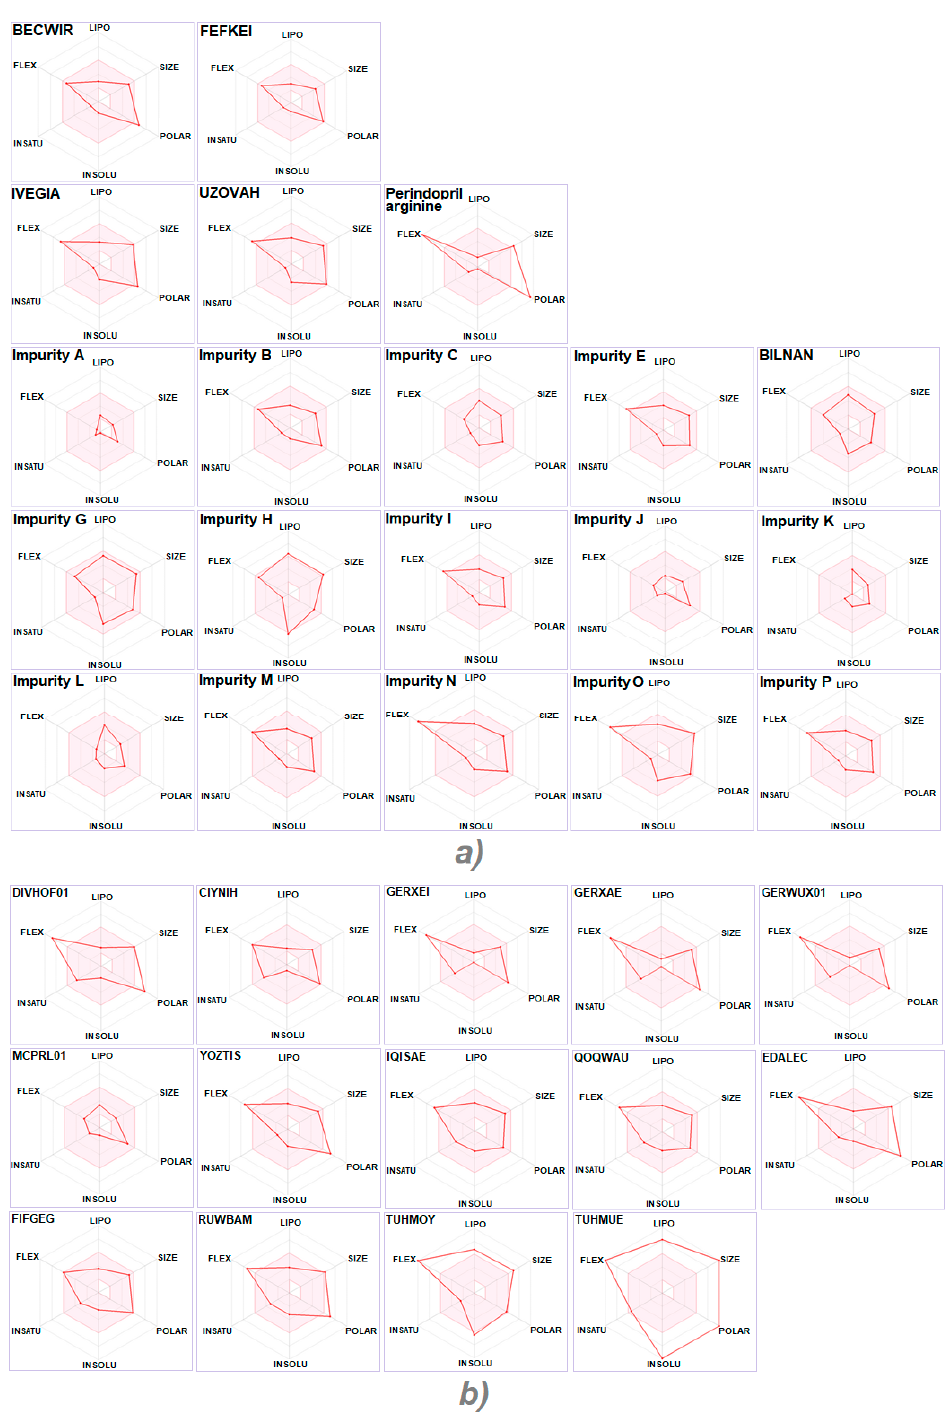
Figure 24. Bioavailability radars of major perindopril-derived compounds ( a ) augmented by remaining proline-based ACEI structures ( b ) as calculated by the Swiss ADME predictor.